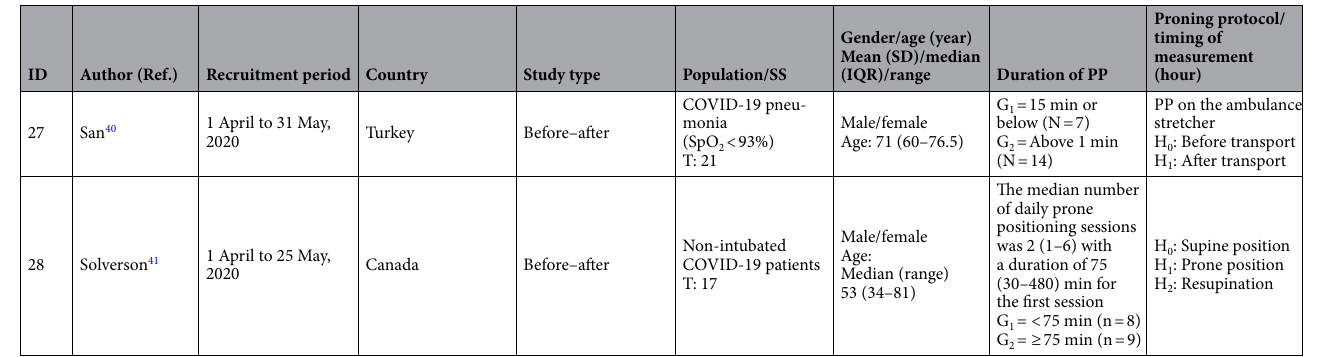
Table 1. Overview of all included studies in systematic review. SS sample size, PP prone position, H hour, min minutes, G group, T total, O 2 oxygen, NIV non invasive ventilation, IMV intermittent mandatory